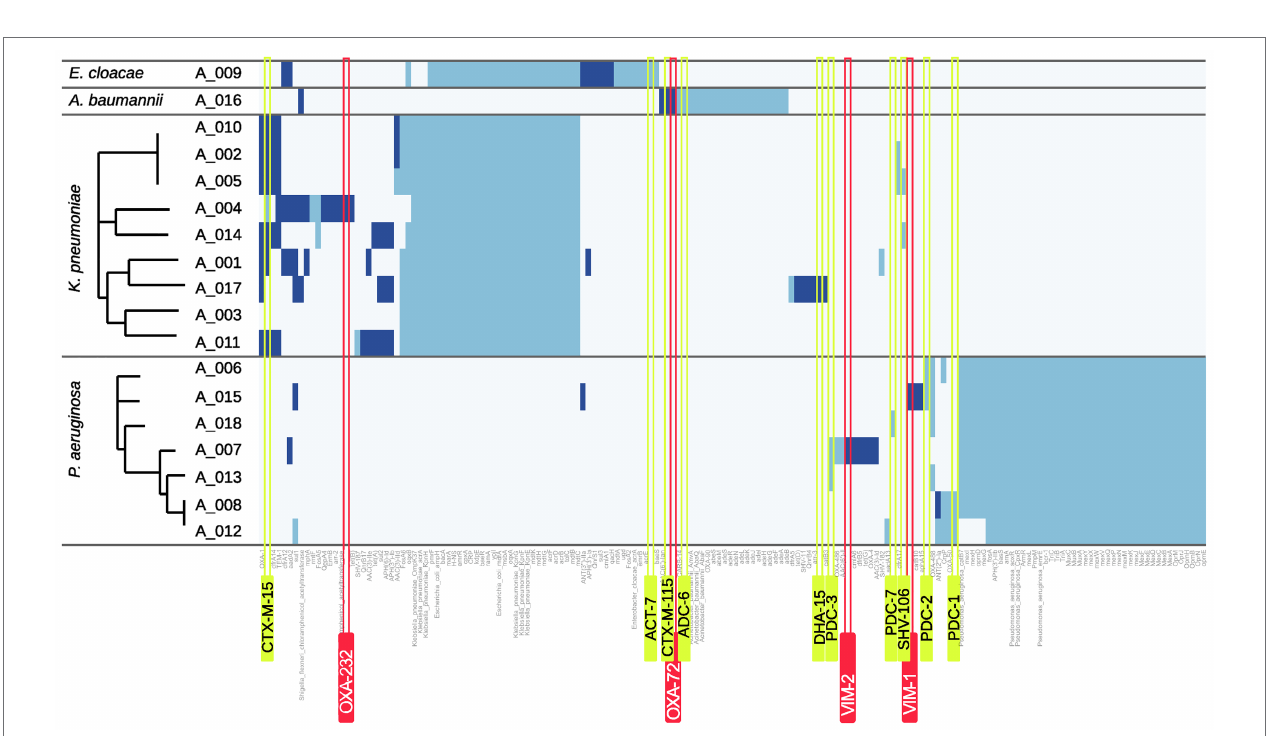
FIGURE 4 | Heatmap of resistance genes. Hits for resistance genes are shown as blue bars. Dark blue indicates that the respective gene is predicted to be plasmid-related whereas light blue indicates a chromosomal origin. Carbapenemase genes are highlighted by red and ampC or ESBL genes by yellow boxes.